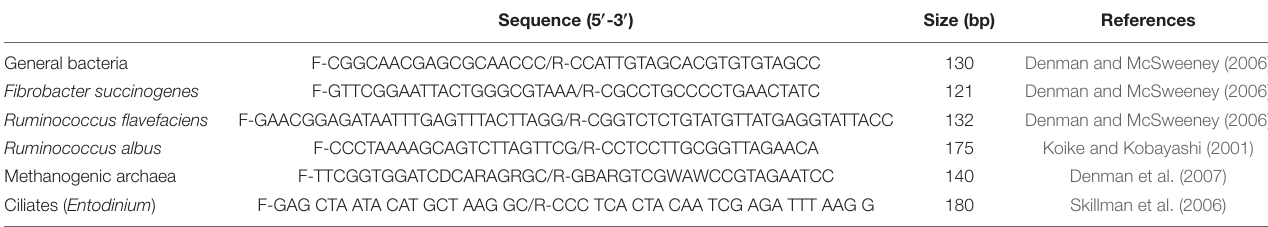
TABLE 1 | Oligonucleotide primers used for real-time PCR assay.